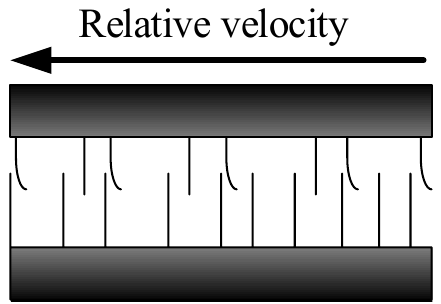
Fig. 2. Bristles-based representation of the friction